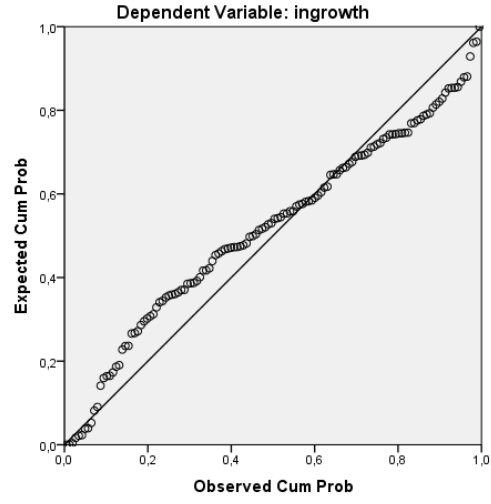
Figure C1. Normal probability plot of regression standardized residual.